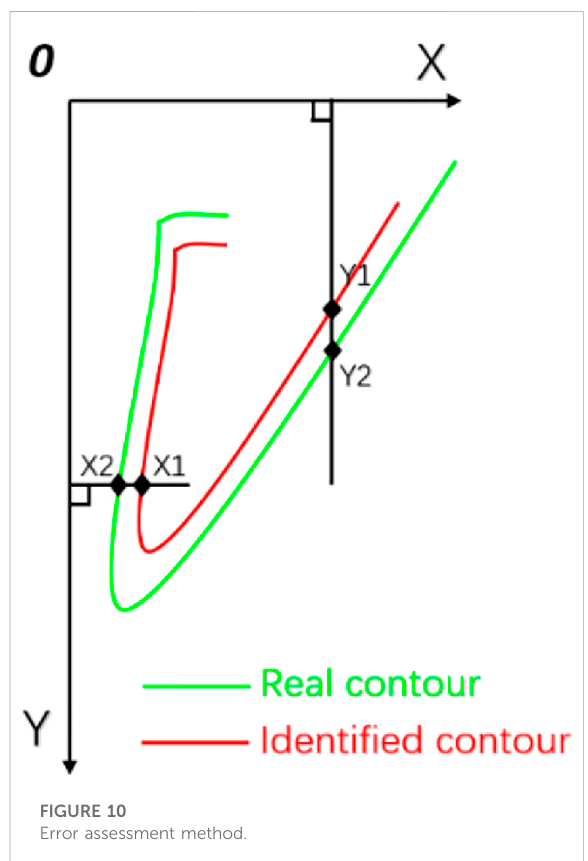
FIGURE 10 Error assessment